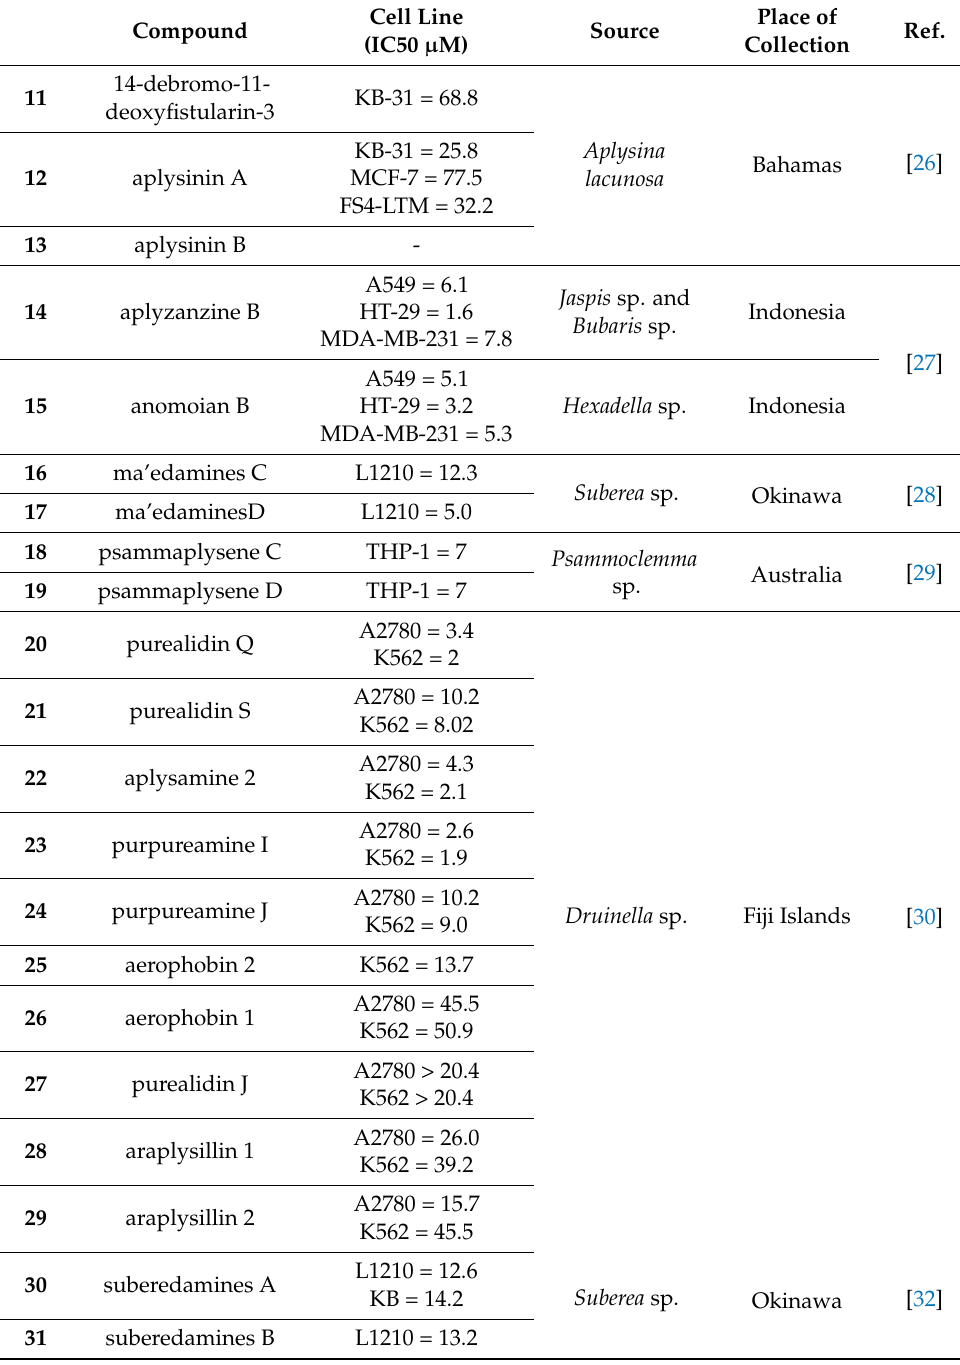
Table 3. Cytotoxic effects of bromotyrosine